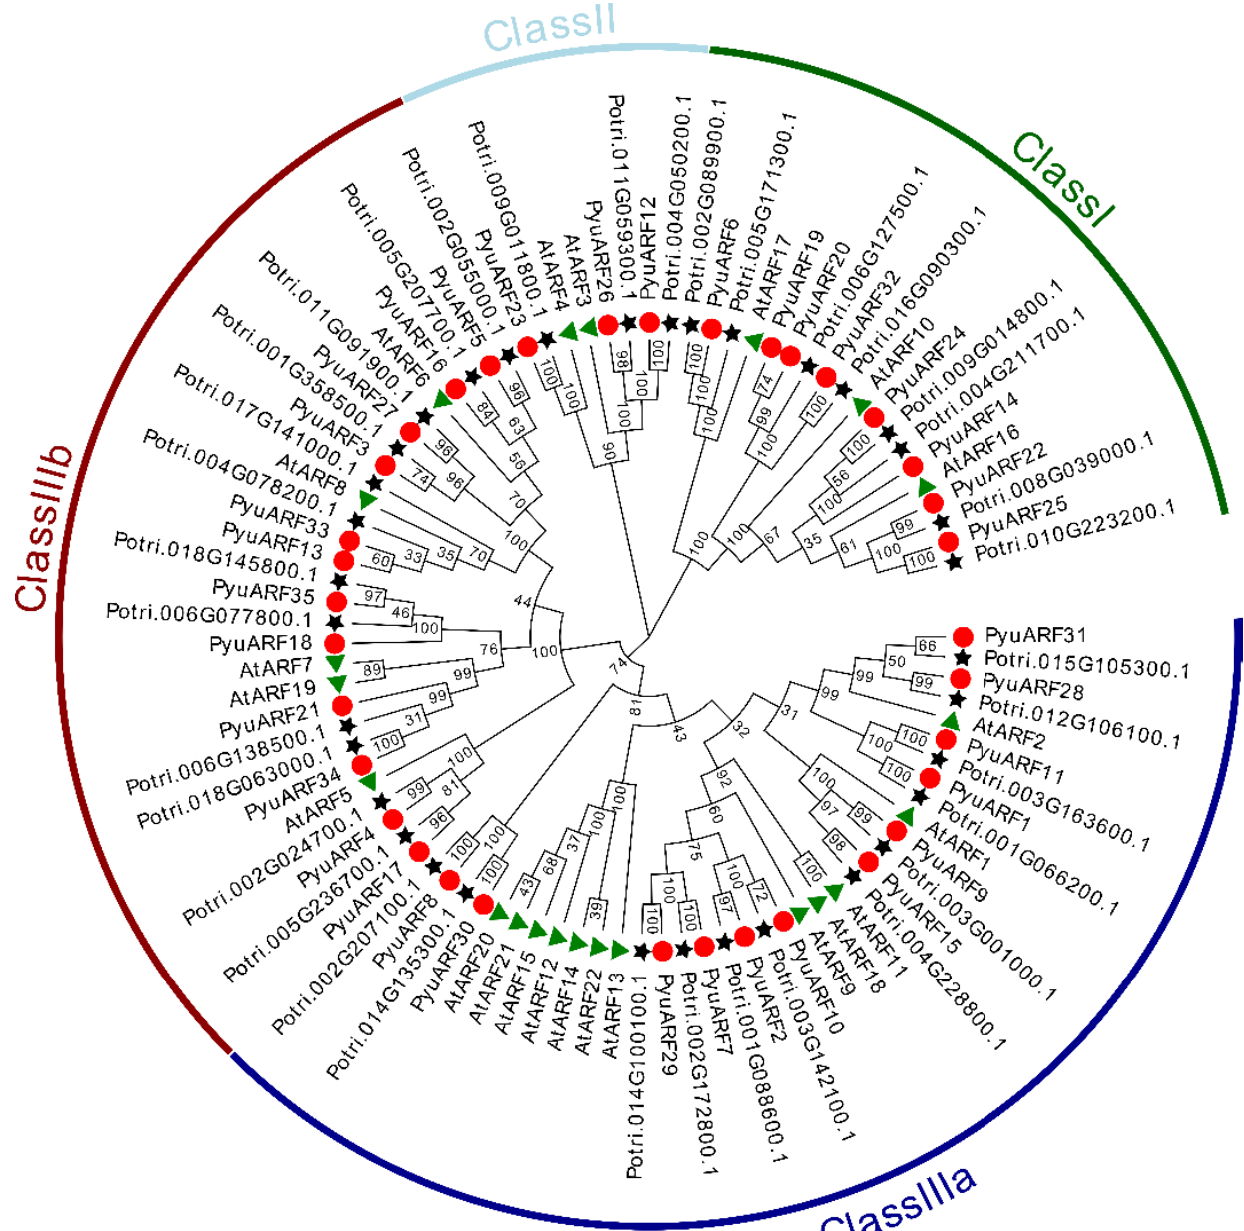
Figure 1. Phylogenetic tree comparison of the ARFs from P. trichocarpa , P. yunnanensis and A. thaliana . We constructed a rootless phylogenetic tree using the protein sequences of the ARF family members, i.e., 22 AtARFs from A. thaliana , 35 PtriARFs from P. trichocarpa , and 35 PyuARFs from P. yunnanensis. The red circles represent the genes of P. yunnanensis , the green triangles represent the genes of A. thaliana , and the black five-pointed stars represent the genes of P. trichocarpa .